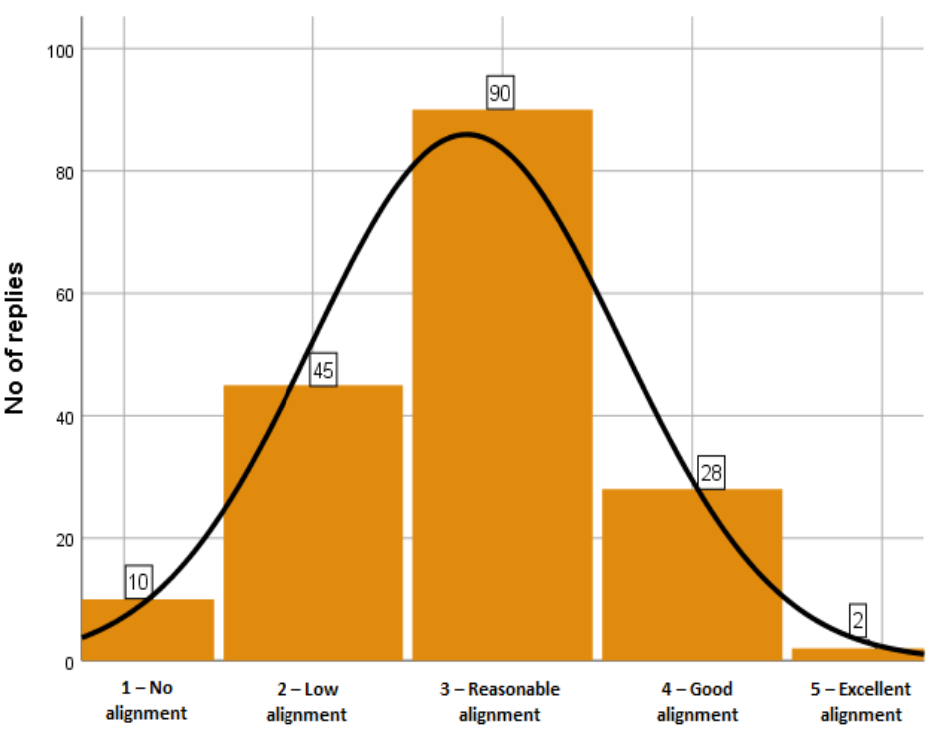
Figure 3. Evaluation of the articulation between the IMSRF and the spatial planning policies ( x = 2.81; SD = ±0.81; N = 175).